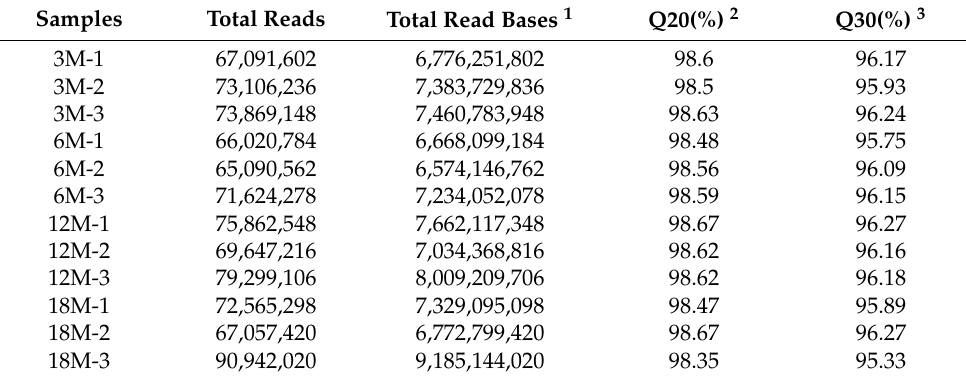
Table 1. Raw data summary for total RNA sequencing of mouse testis from different age groups.